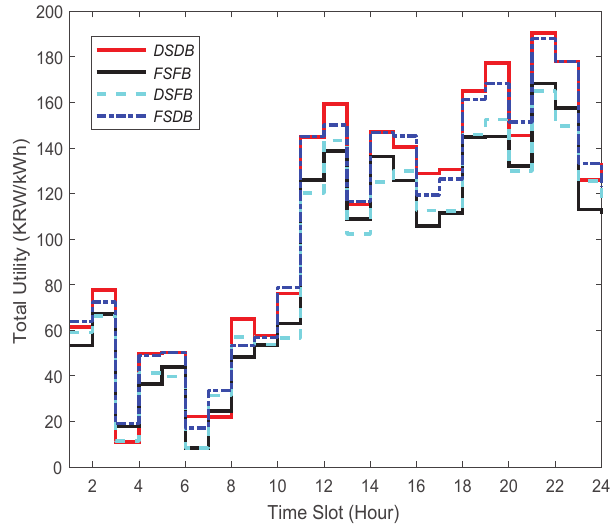
Figure 8. Total utility in the case in which the energy broker has high-cost ESS.